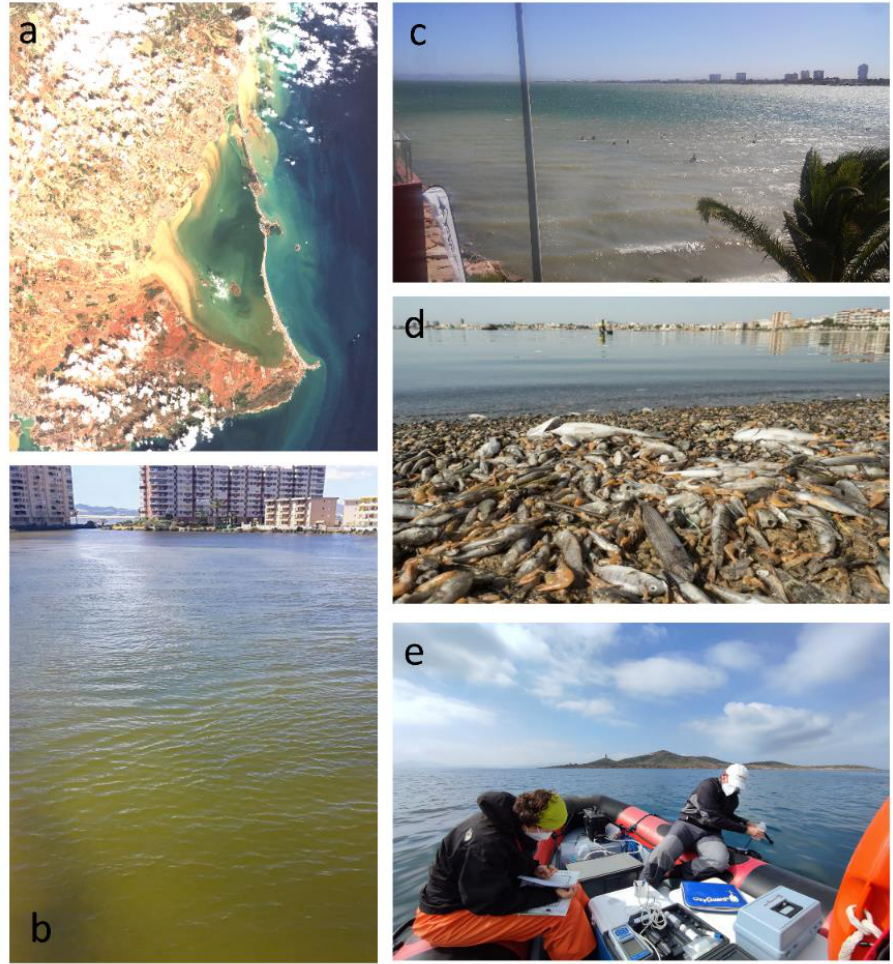
Figure 3. ( a ) Sentinel-2 scene in Mar Menor after the extreme weather event known as the “Cold Drop” and the catastrophic flooding on 13 September 2019; ( b ) surface of the water in the lagoon in July 2016 during the environmental crisis; ( c ) typical resuspension of sediments and increased turbidity during strong winds; ( d ) latest environmental catastrophe with massive dead fish and crustacean in August 2021 (authorship: Greenpeace); and ( e ) field campaign carried out in the lagoon in March 2021.